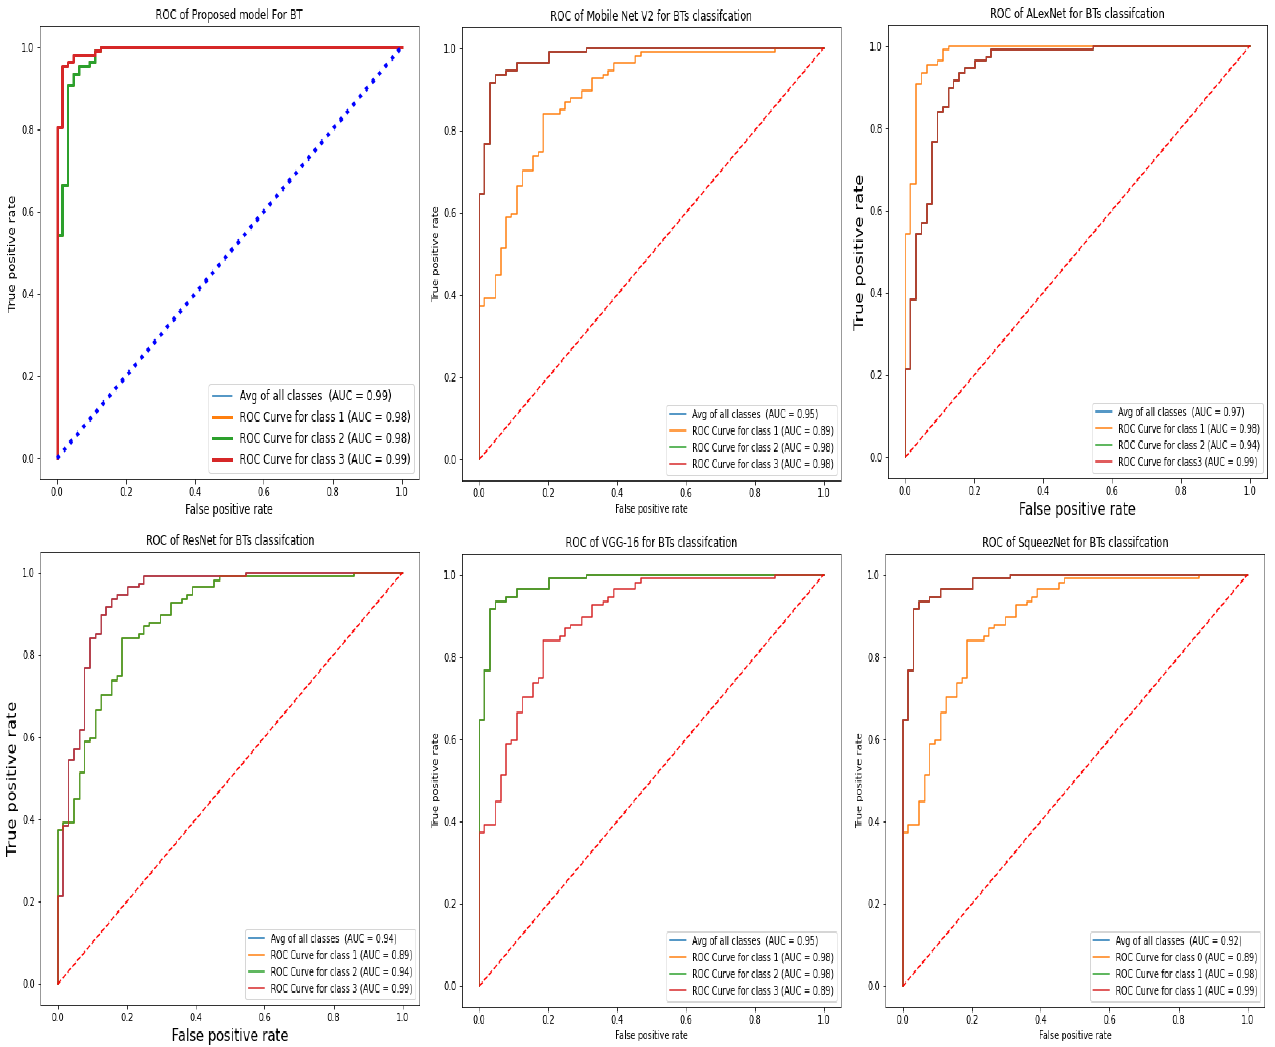
Figure 8. The ROC of the proposed model with transfer learning techniques in brain tumor detec- tion.